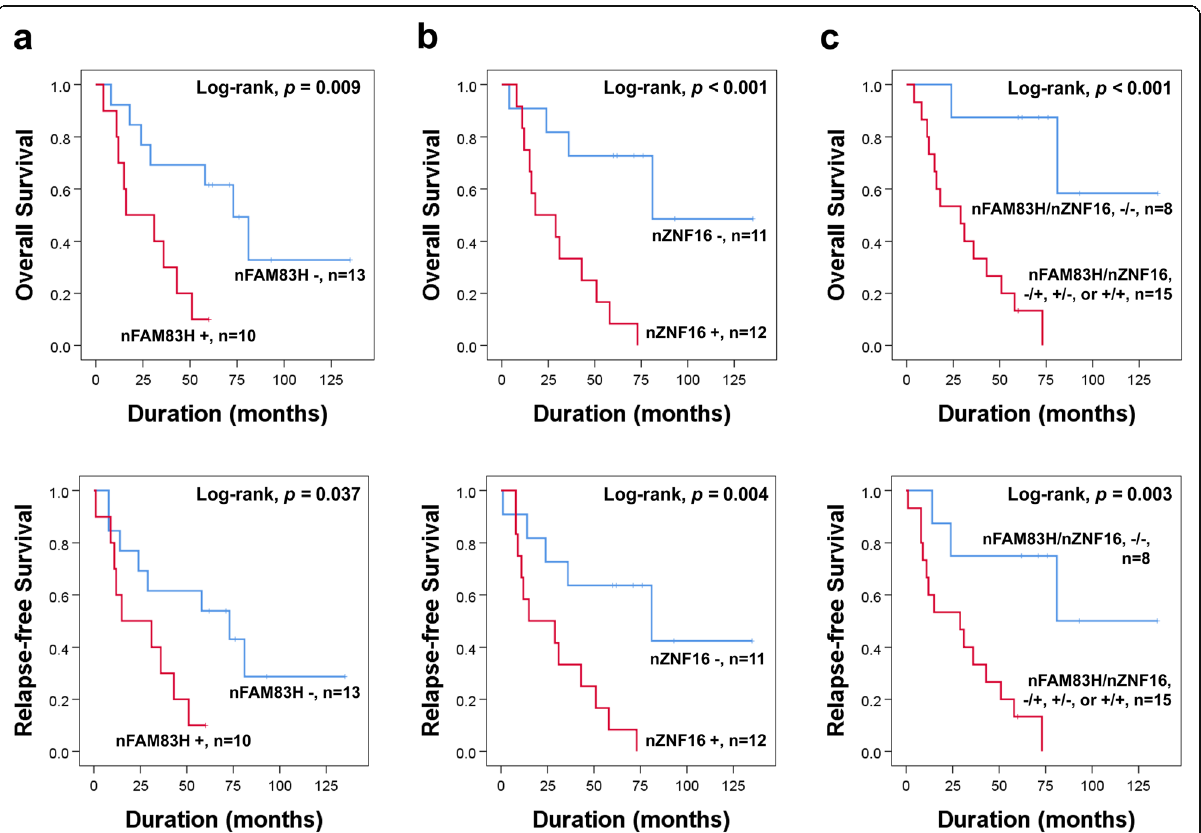
Fig. 4 Survival analysis according to the individual and co-expression patterns of nuclear FAM83H and nuclear ZNF16 in 23 gallbladder carcinoma patients who received adjuvant chemotherapy. a Survival analysis for overall survival and relapse-free survival according to the expression of nuclear FAM83H (nFAM83H). b Survival analysis for overall survival and relapse-free survival according to expression of nuclear ZNF16 (nZNF16). c Survival analysis in two prognostic groups of gallbladder carcinomas according to co-expression patterns of nuclear FAM83H and nuclear ZNF16: [nFAM83H − /nZNF16 − ] and [nFAM83H − /nZNF16 + , nFAM83H + /nZNF16 − or nFAM83H + /nZNF16 + ]